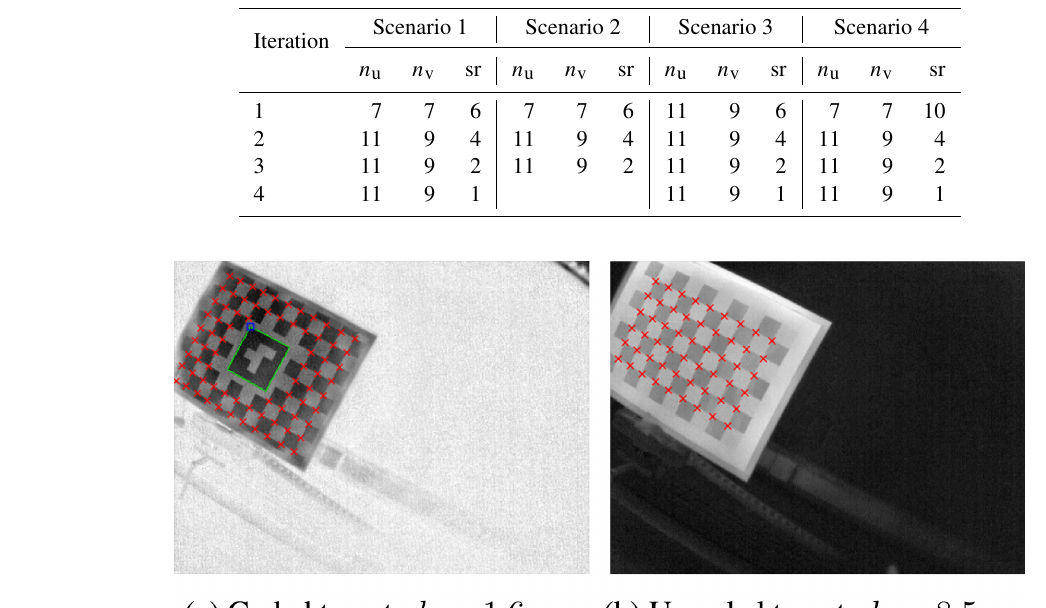
Table 1. Test scenarios for the parameterization of n u , n v and sr.